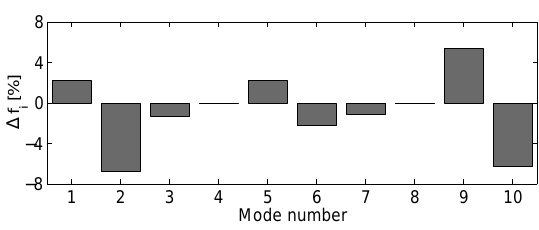
Fig. 3. Frequency deviations of the model updated from the design